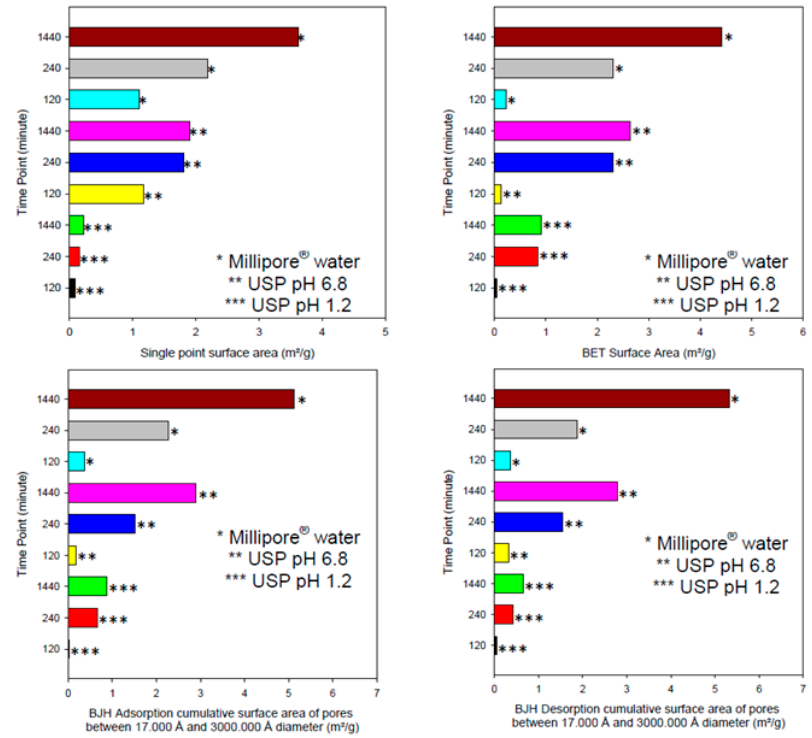
Figure 6. Porositometric surface area analysis with respect to time of the hydrogel within simulated gastric fluid (pH 1.2), simulated intestinal fluid (pH 6.8) and Millipore ® water.